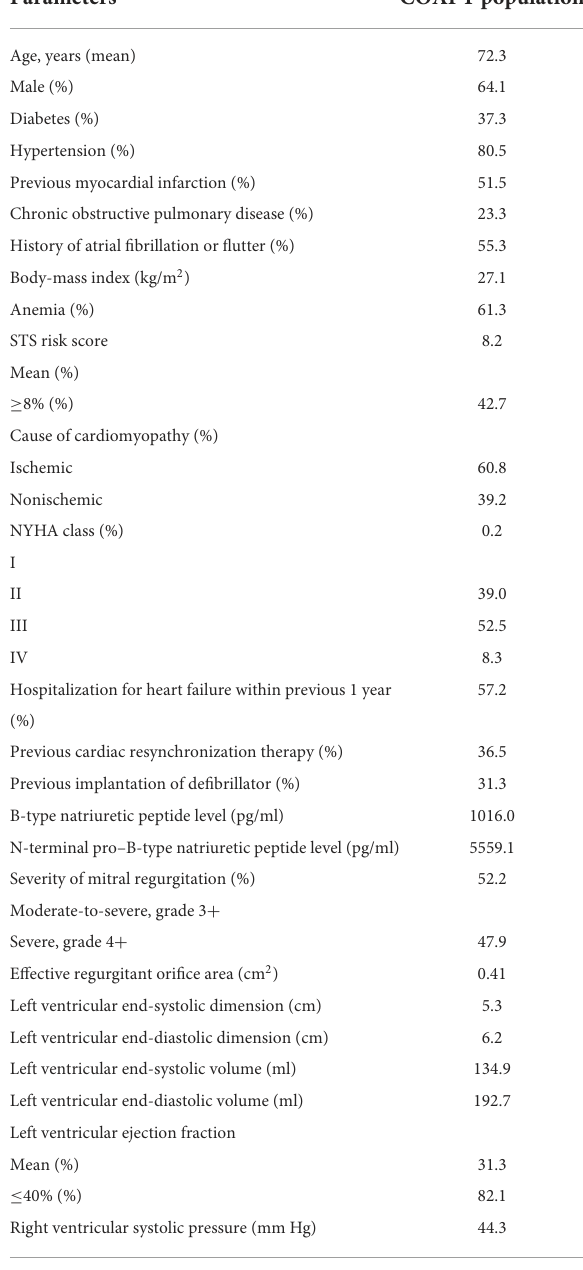
TABLE 3 Model input values for baseline patient characteristics of the COAPT